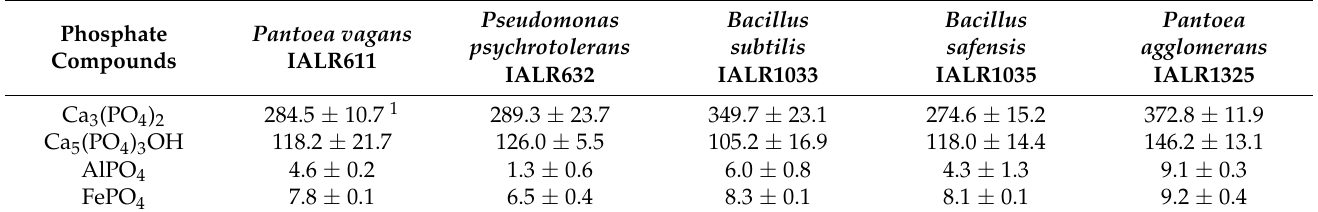
Table 2. The solubilization of different insoluble phosphate compounds by bacterial endophytes.